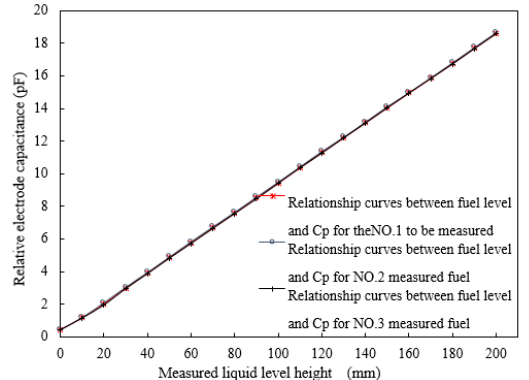
Figure 6. Relationship between fuel level and average output capacitance of the C P during the forward